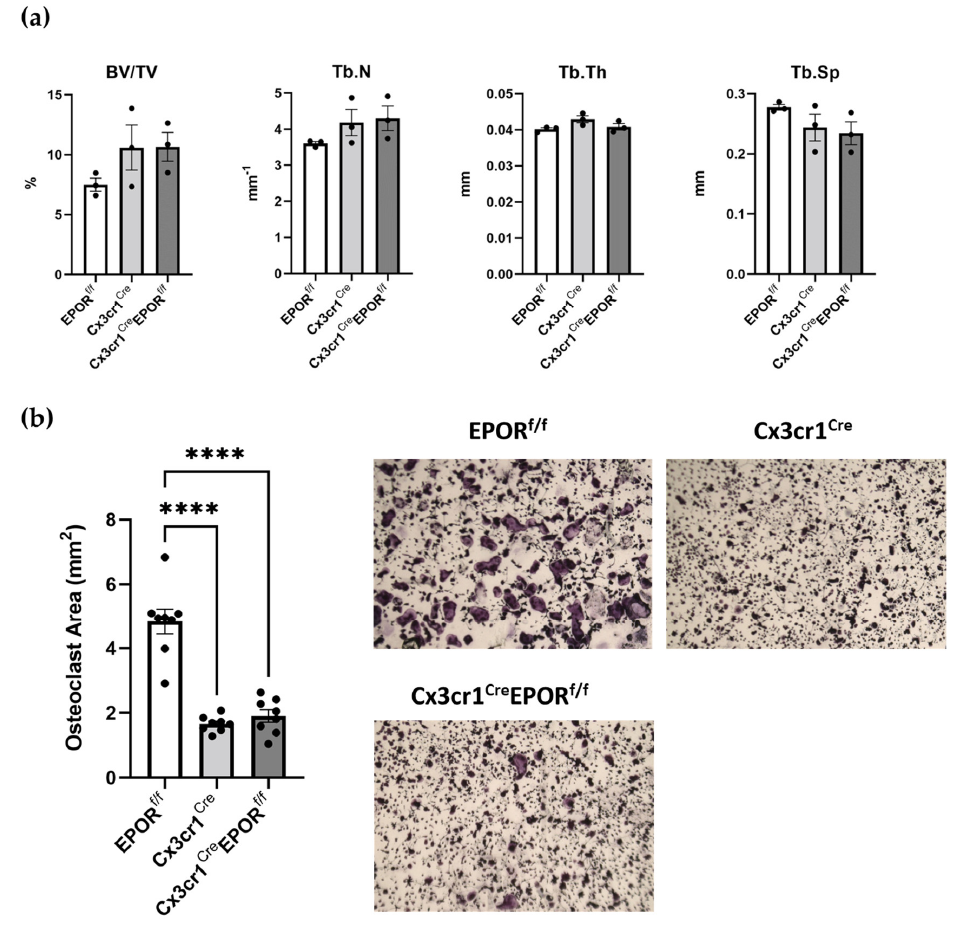
Figure 1. Monocyte-specific EPOR knockout has no effect on trabecular bone mass. ( a ) μCT anal-